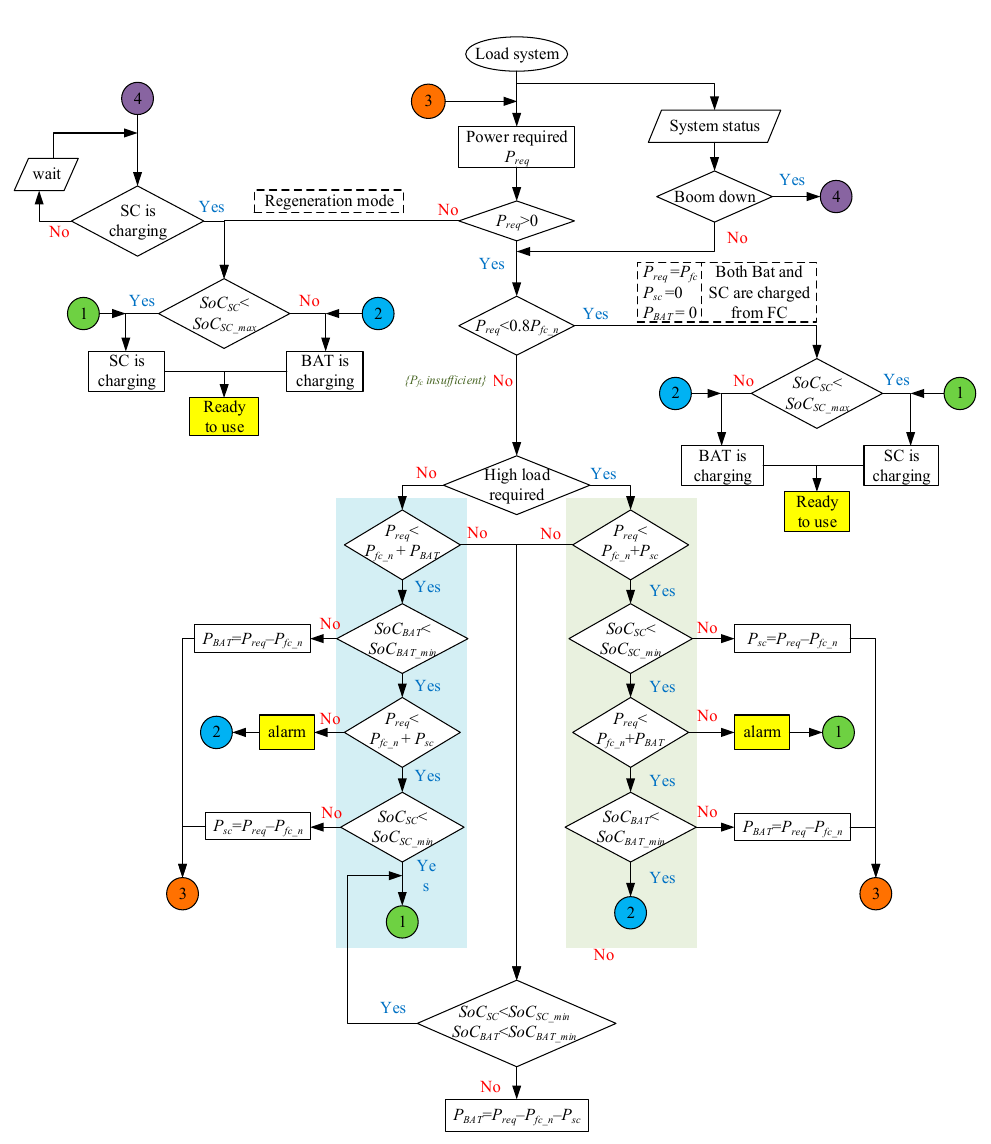
Figure 4. The proposed strategy for energy management strategy (EMS) with the regeneration part.